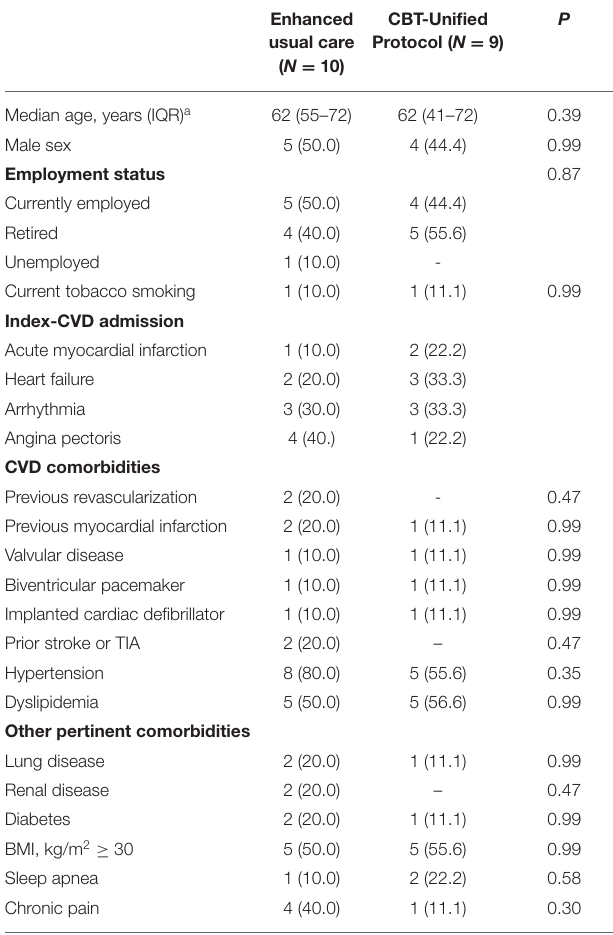
TABLE 1 | Baseline demographic and cardiovascular characteristics of the sample N